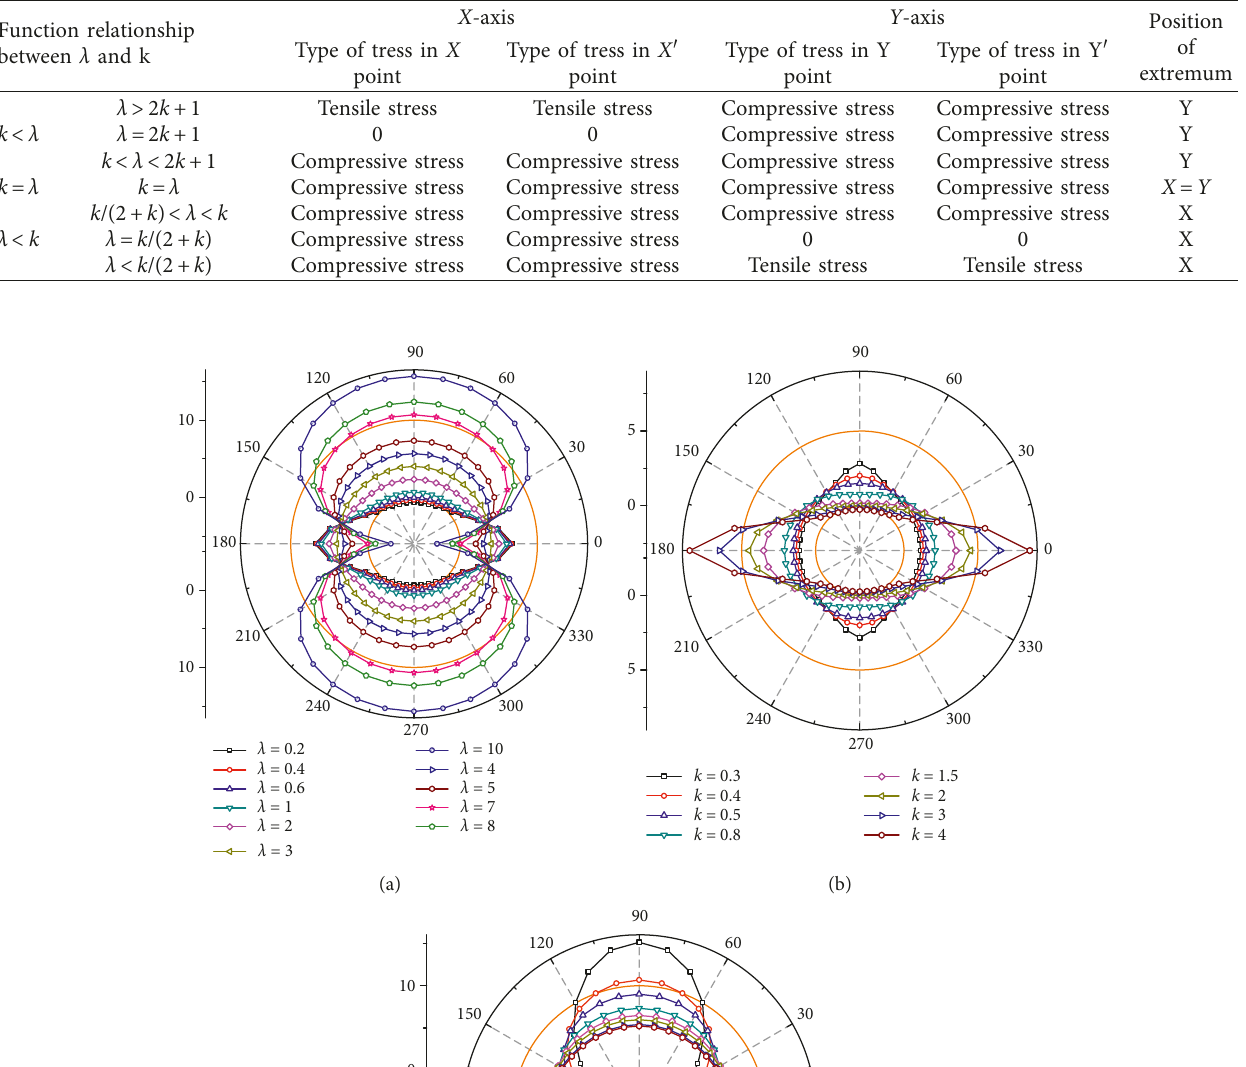
Table 1: Types of tangential stress and maximum location on the equivalent ellipse.